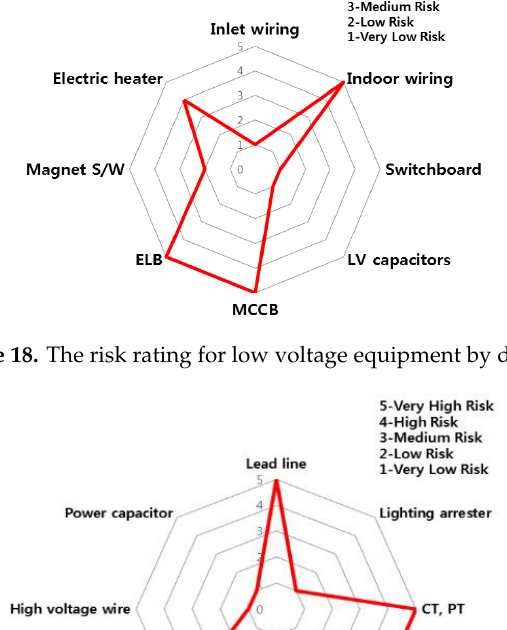
Figure 18. The risk rating for low voltage equipment by device. Table 9. The number of accidents and risk rating for high voltage equipment.